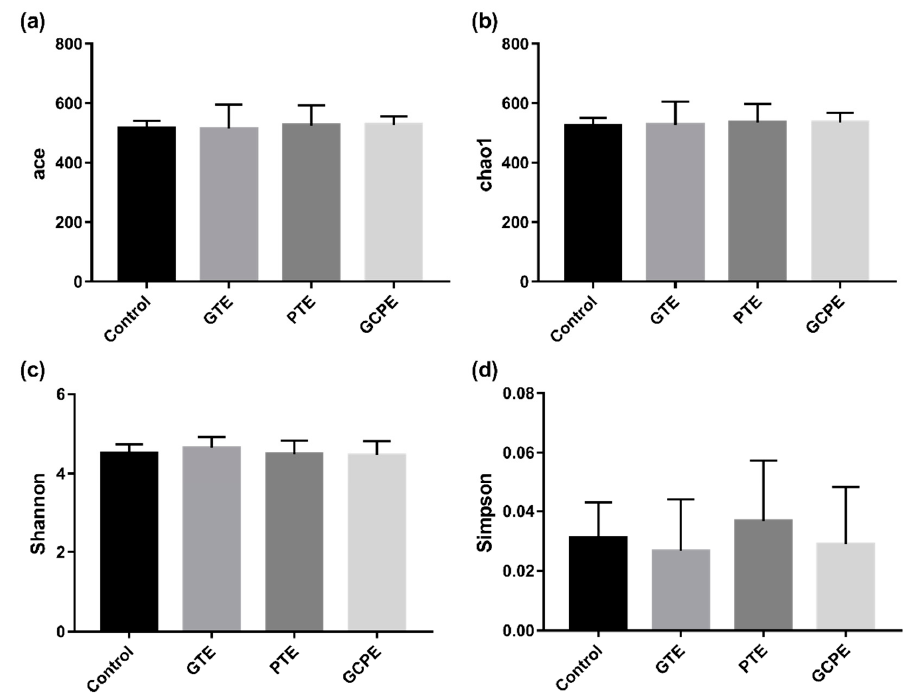
Figure 5. The diversity index, including ACE ( a ), Chao1 ( b ), Shannon ( c ) and Simpson index ( d ), of gut microbiota in rats in different groups ( n = 10).